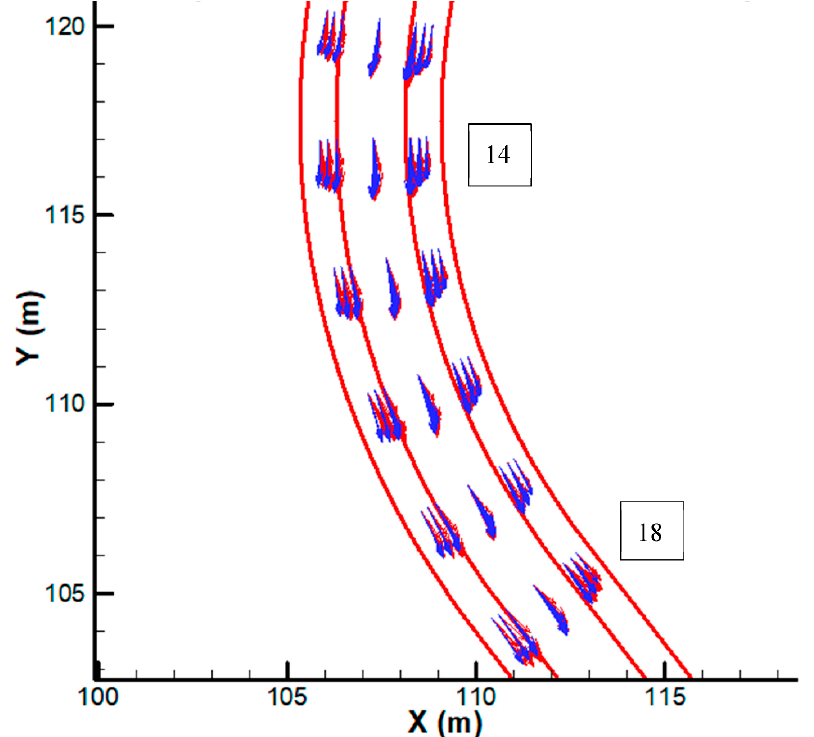
Figure A11. Plan-view comparison of simulated (blue) and measured (red) velocity vectors for the upstream portion of the downstream channel curve.